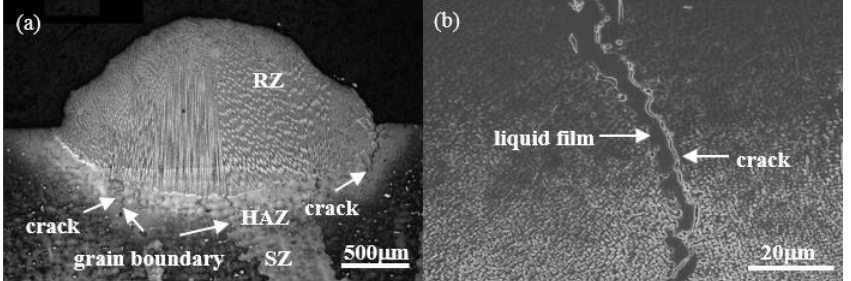
Figure 2. Morphology and cracking characteristics of LFRed K465 specimen: ( a ) morphology of LFRed specimen and ( b ) cracking characteristics in HAZ.